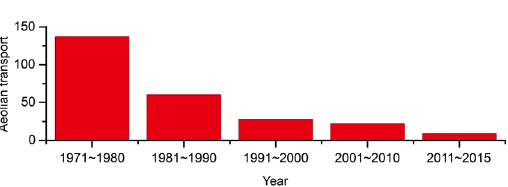
Figure 4. Temporal variation in aeolian transport (10 4 ton km − 2 ) in the Mu Us